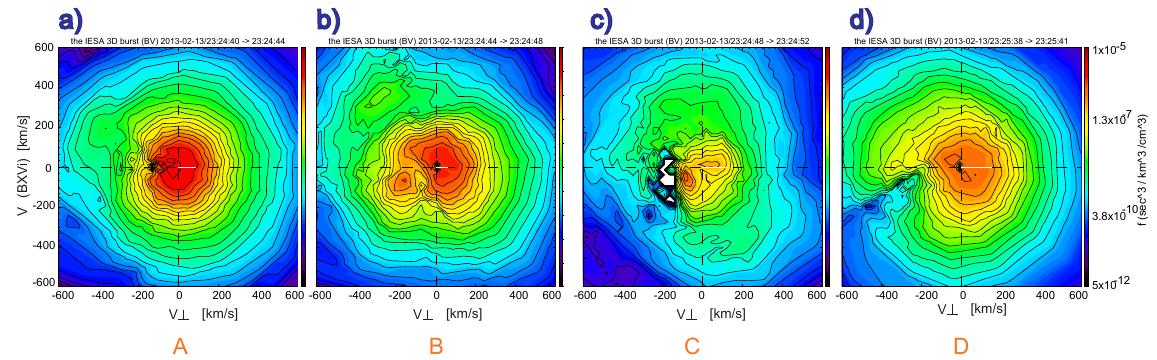
Figure 3. Observations of ion velocity distributions near and within the ion diffusion region. Panels (a–d) : the cut of velocity distribution functions perpendicular to the magnetic field measured from THEMIS ESA in the intervals marked as A, B, C, and D in Fig. 2. The horizontal axis is the direction of ion convection flow V i ⊥ and the vertical axis is the direction of B × V i ⊥ . The ion bulk flow velocity has been subtracted from the distributions. The white horizontal line in the distribution represents the flow convection velocity in the spacecraft frame. Interval A is far from the diffusion region, B and C are within the diffusion region and D is at the edge of the current layer and away from the current sheet